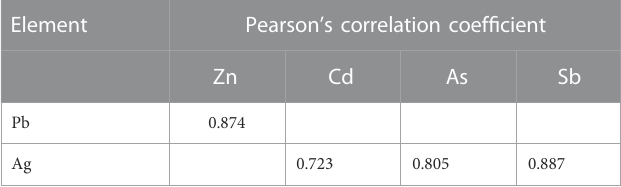
TABLE 1 Pearson ’ s correlation coef fi cients between signi fi cant geochemical indicator